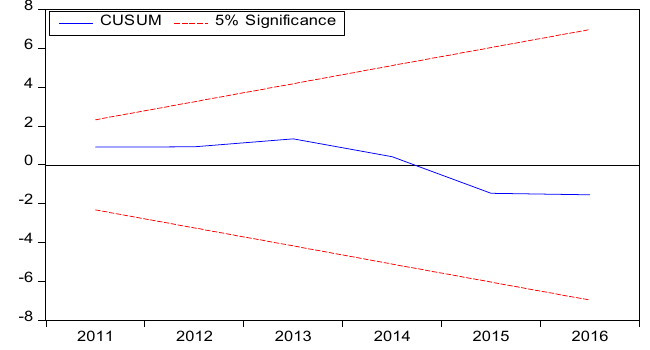
Figure 1. Cumulative sum (CUSUM) test.